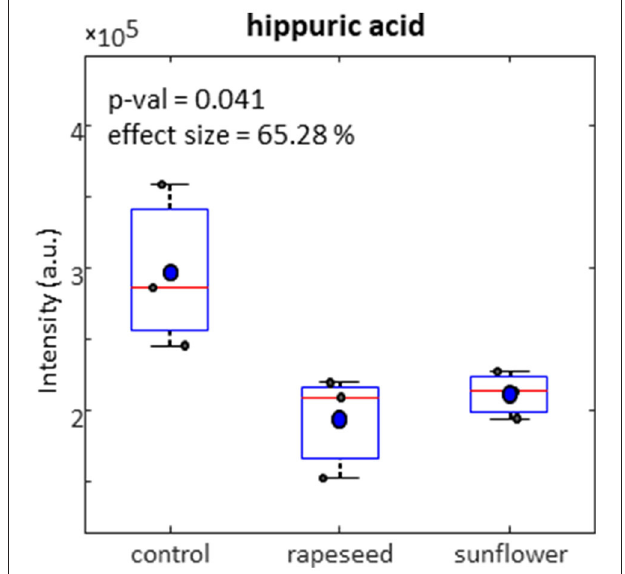
FIGURE 1 | Relative concentration of hippuric acid in goat milk detected by 1 HNMR spectroscopy across control, rapeseed oil and sunflower oil